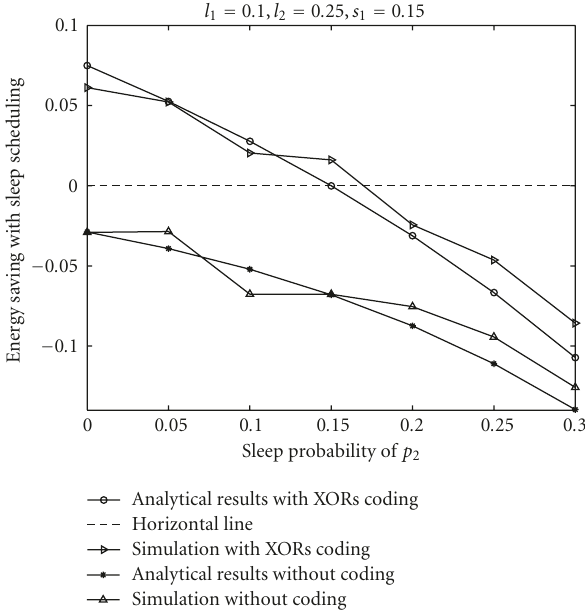
Figure 8: Energy saving versus sleep probability of sensor p 2